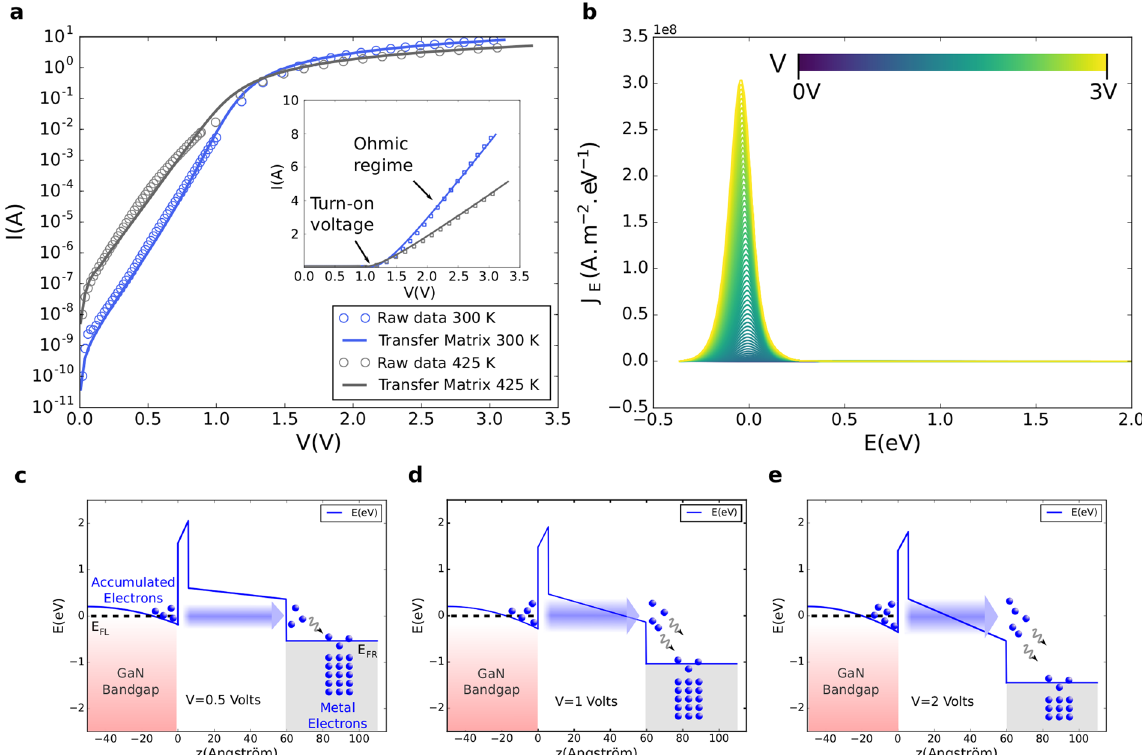
Figure 7. Calculated tunnel current and related current spectroscopy. ( a ) Semilog plot of the I(V) characteristics of the recessed diode at 300 K and 425 K reproduced using the model exposed. Inset : Linear plot showing the ohmic regime above the turn-on voltage at both temperatures. ( b ) Current density per unit area and energy as a function of energy at all voltages at 300 K. E = 0 denotes the Fermi energy in the bulk GaN. ( c – e ) Calculated conduction band profiles of the rectifying contact at room temperature and for applied biases of 0.5, 1 and 2 V. The shaded area in the accumulation layer represents the main energies contributing to the total current. Note that the contact sees an effective voltage drop of V − RI which is noticeable above the turn-on voltage, that is to say case ( e) in the present situation.